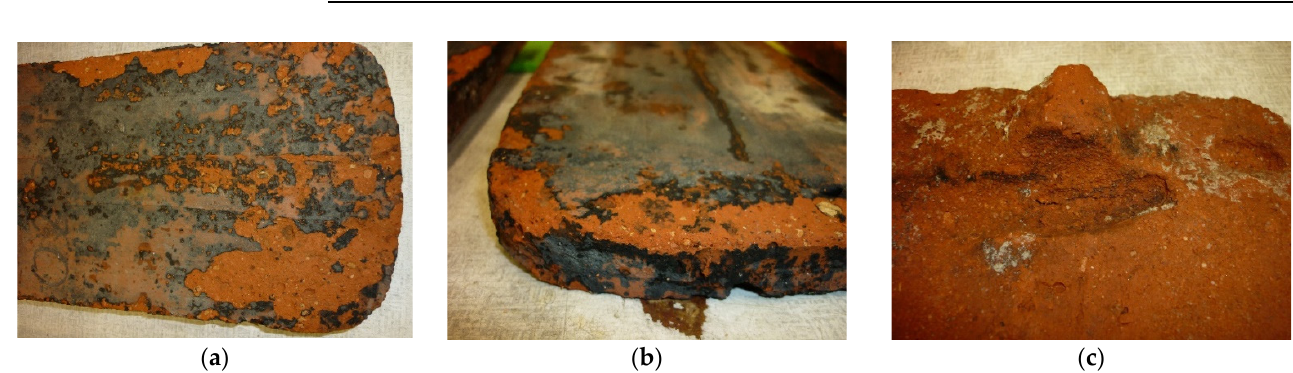
Figure 8. Frost resistance test: ( a ) surface damage observed after the test; ( b ) edge damage observed after the test; and ( c ) damage observed after the test.